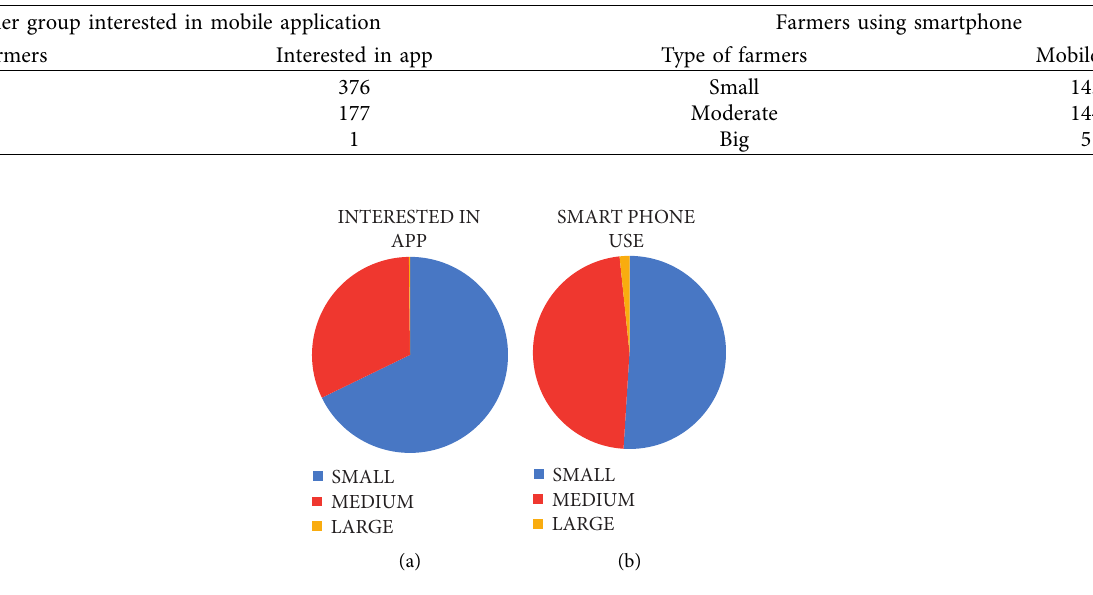
Figure 12: Interpretation of type of farmers versus interested in mobile app.